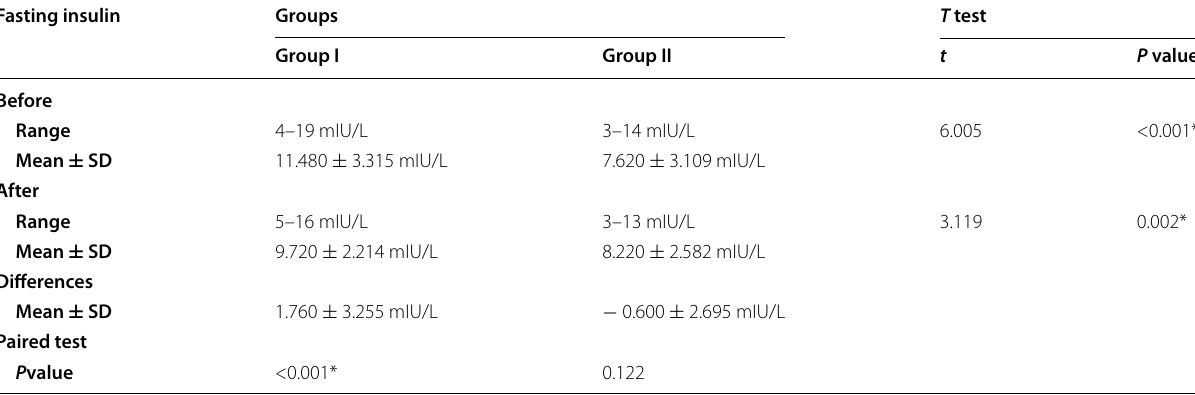
t Student’s t test, p p value for comparing between the two